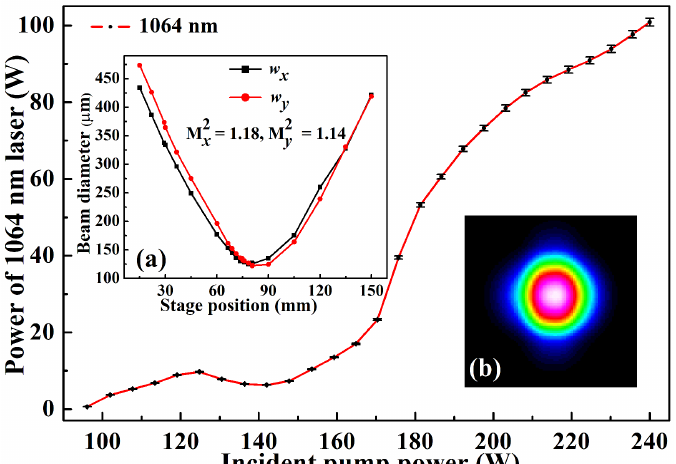
Figure 6. Schematic diagram of a 101 W single-frequency CW 1064 nm laser [25]. Reprinted with permission from [25] c (cid:13) The Optical Society.